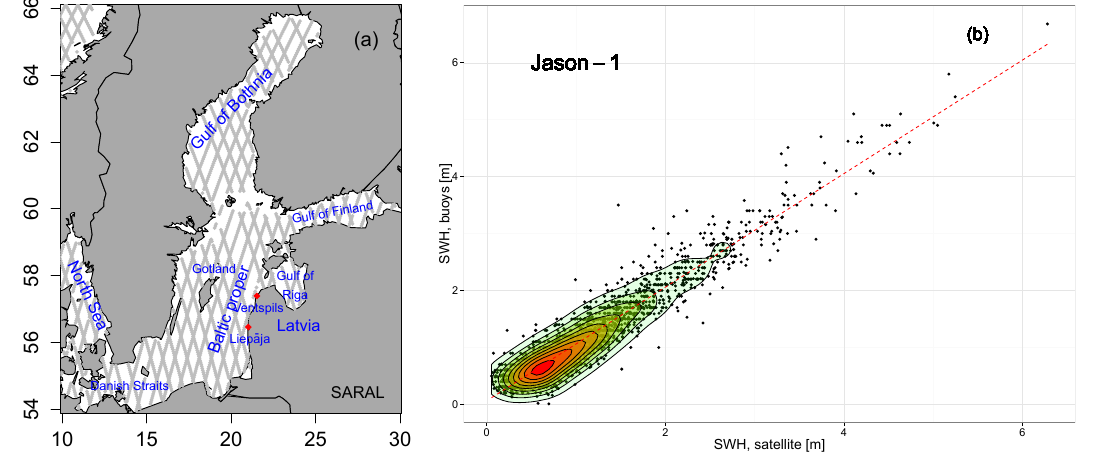
Figure 1. Validation of satellite altimetry data: (a) an example of the monthly visits of SARAL to the Baltic Sea region; (b) a comparison of SWH derived using Jason-1 and in situ data. Adapted from Kudryavtseva and Soomere (2016).